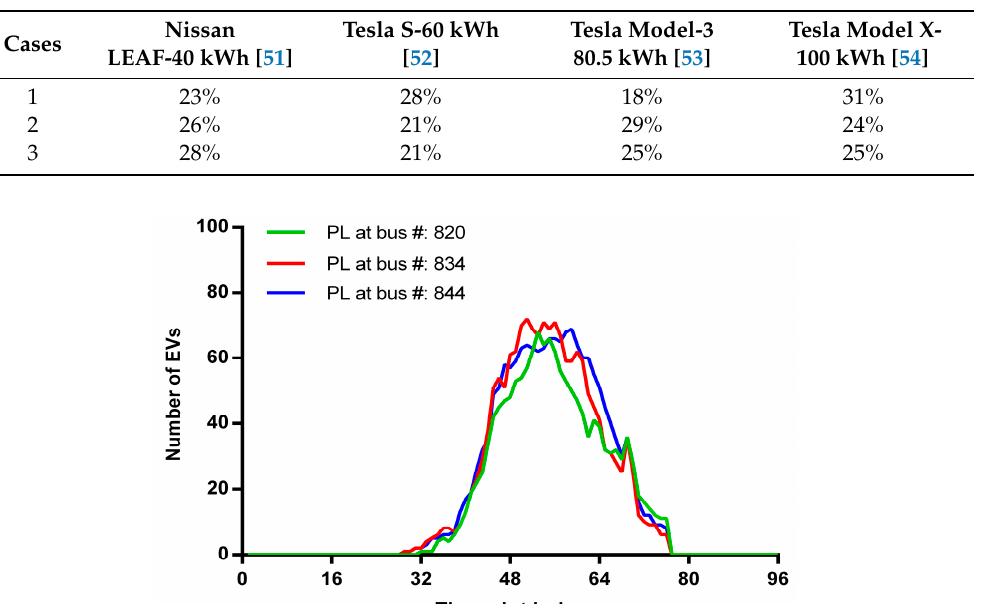
ff erent PLs connected to the three